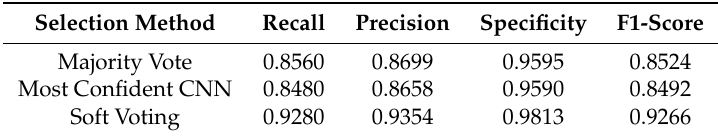
Table 8. Pose recognition results achieved using the four corner TISs with three methods of prediction selection.